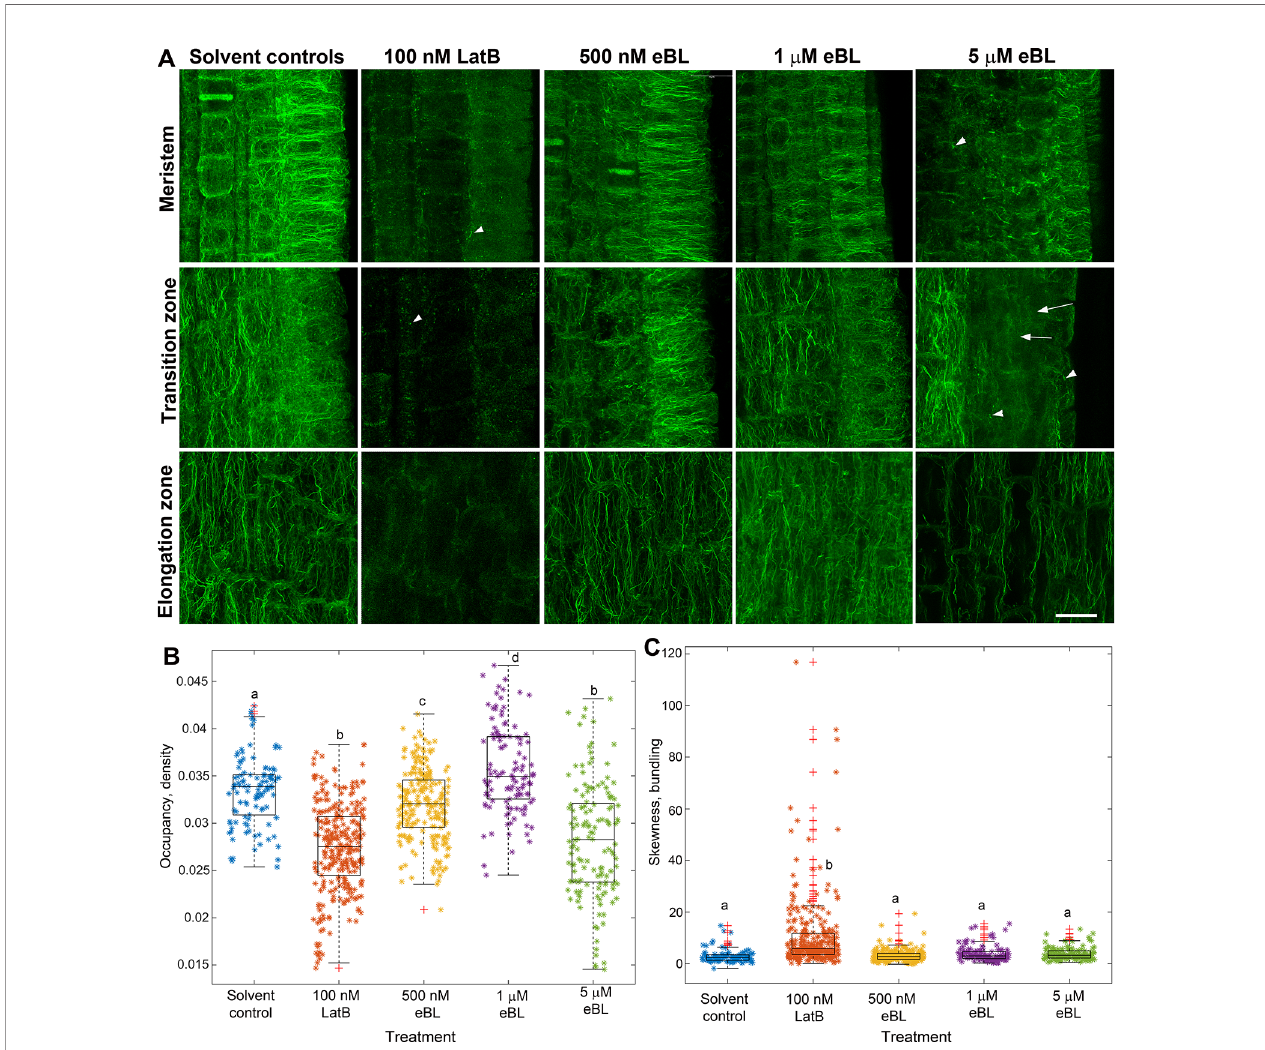
FIGURE 2 | Epi-Brassinolide (eBL) modi fi ed F-actin organization in Z. mays roots. (A) Single optical confocal micrographs of chemically- fi xed and longitudinally- sectioned Z. mays roots stained with Alexa Fluor 488-phalloidin. Note that LatB-treated roots had diffuse staining and fragmentation of F-actin in the form of puncta and short fi laments (arrowheads). Untreated (solvent controls) had extensive F-actin networks. 500 nM and 1 µM eBL on the other hand did not result in any visible effects on F-actin. At 5 µM eBL, some regions of the meristem, transition and elongation zone have diffuse fl uorescence (arrows) and fragmented F-actin (arrowheads). (B , C) Combined box and scatter plots showing quantitative analysis of F-actin occupancy (density B ) and skewness (bundling C ) in root cells of the transition/elongation zone. Statistical signi fi cance was determined by one-way ANOVA. Asterisks (*) refers to individual data points and + mark outliers. Bars are means (n > 100 cells) ± S.E. Different letters indicate signi fi cant differences among means (P < 0.05, Tukey ’ s test). Scale bars = 20 m